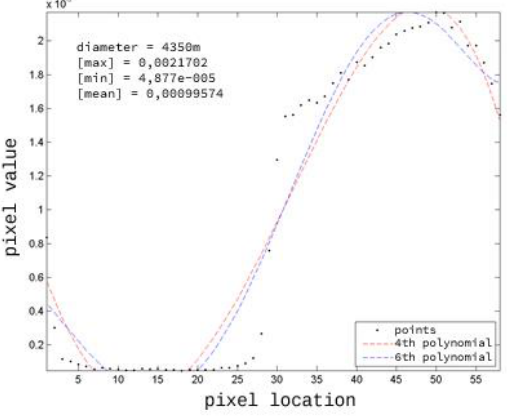
Figure 7. The example of detected crater profile